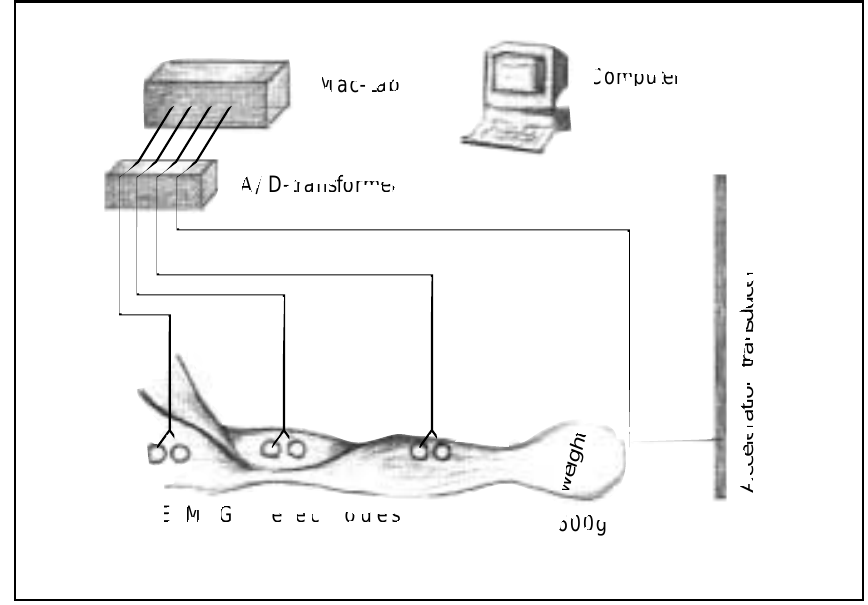
Figure 1: Testing procedure.